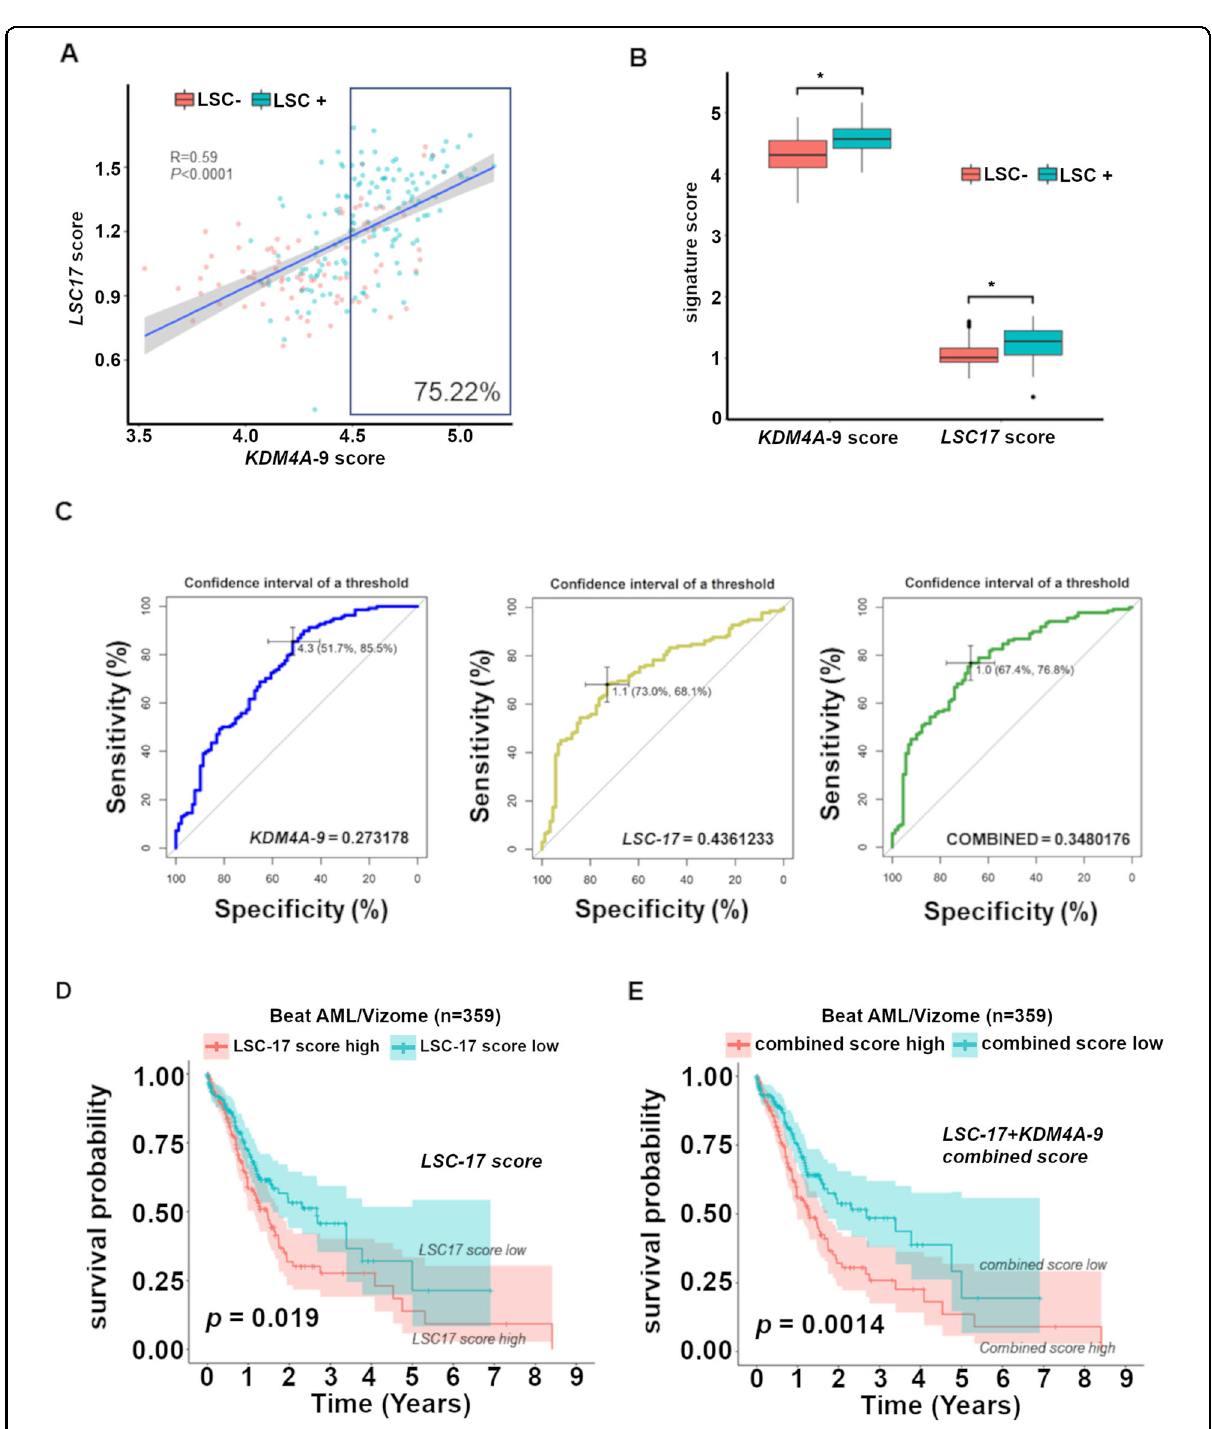
Fig. 7 KDM4A-9 enriched with LSC activity, is a poor prognosis marker for AML. A Scatterplot showing a moderate correlation between the KDM4A-9 score and LSC17 score in primary AML patient samples (GSE76008). LSC enriched (LSC + , n = 138) cell fractions from 78 patient samples are colored blue whilst those that lack LSC enrichment (LSC − , n = 89) are colored red. Over 75% of KDM4A-9 high score (above median value) fractions are LSC + . Pearson correlation used to assess correlation. Signi fi cance determined by t -test. B Box plot showing KDM4A-9 or LSC17 signature scores in two comparative groups: LSC + and LSC − from ( A ); unpaired t -test, * p <0.0001. C ROC curves of KDM4A-9 (blue), LSC17 (yellow), and KDM4A-9/LSC17 (green) show the diagnostic capability of each signature to predict LSC enrichment in AML samples. The black bars in each plot are the 95% con fi dence intervals for the optimal cut-off. The Youden index was used to determine the optimal cut-off for each signature. D – E Patients in the Beat AML/Vizome dataset were dichotomized into high and low groups based on whether they possessed a score above or below the median signature score. Kaplan-Meier survival analysis conducted showing that the combined KDM4A-9 / LSC17 score ( E ) is effective in the prediction of AML patient survival over the LSC17 score alone ( D